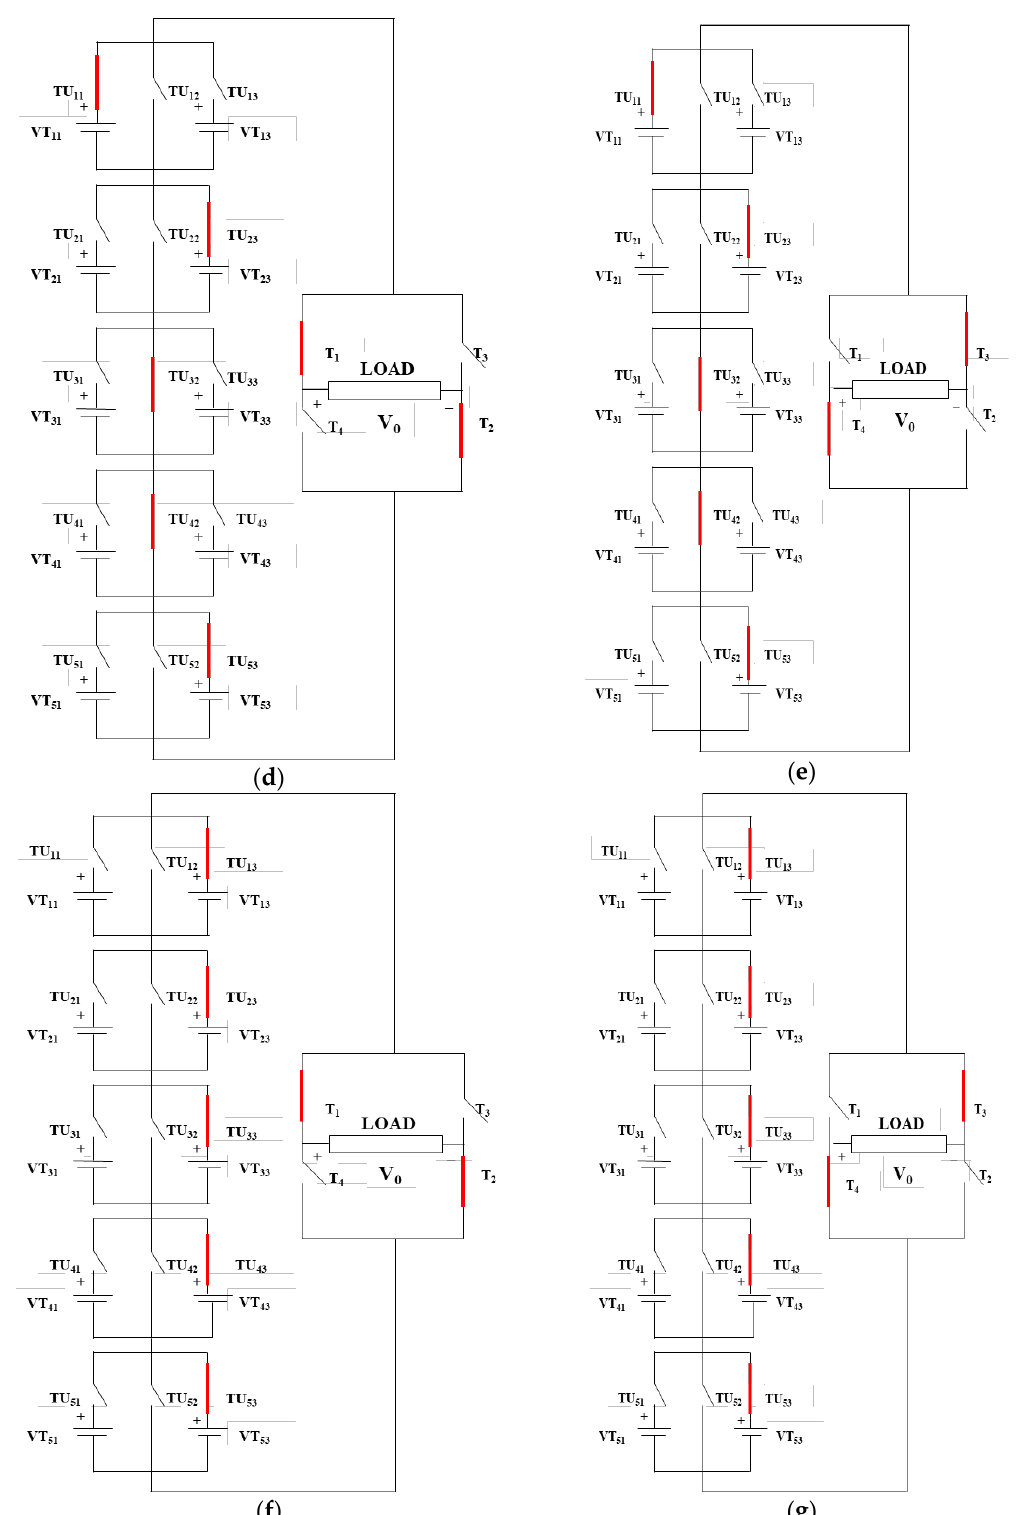
Figure 5. ( a ). Switch representation for 0 V; ( b ). Switch representation for 1 V; ( c ). Switch representation for negative 1 V; ( d ). Switch representation for 169 V; ( e ). Switch representation for negative 169 V; ( f ). Switch representation for 242 V; ( g ). Switch representation for negative 242 V.